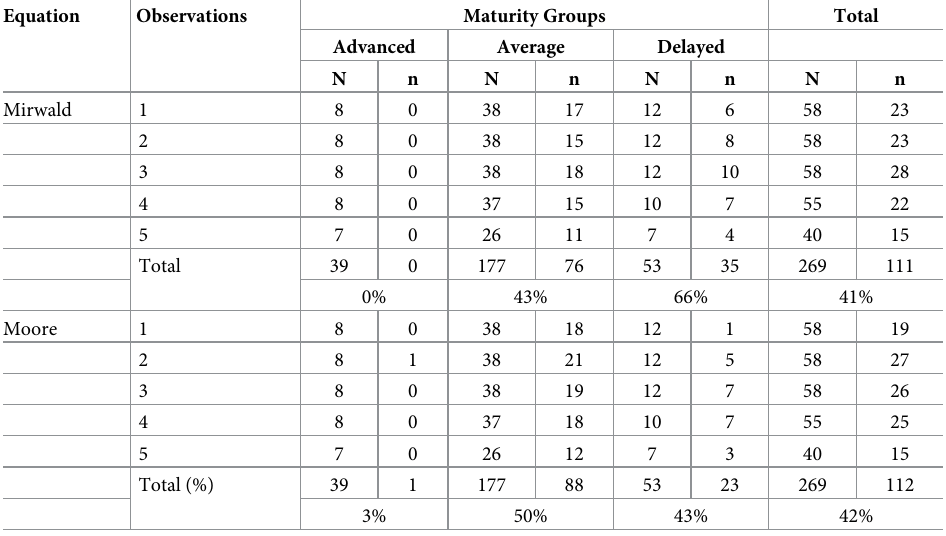
† Players were classified as advanced, average or delayed on the basis of their observed age at PHV (SITAR model) relative to age at PHV for the total sample—see text for